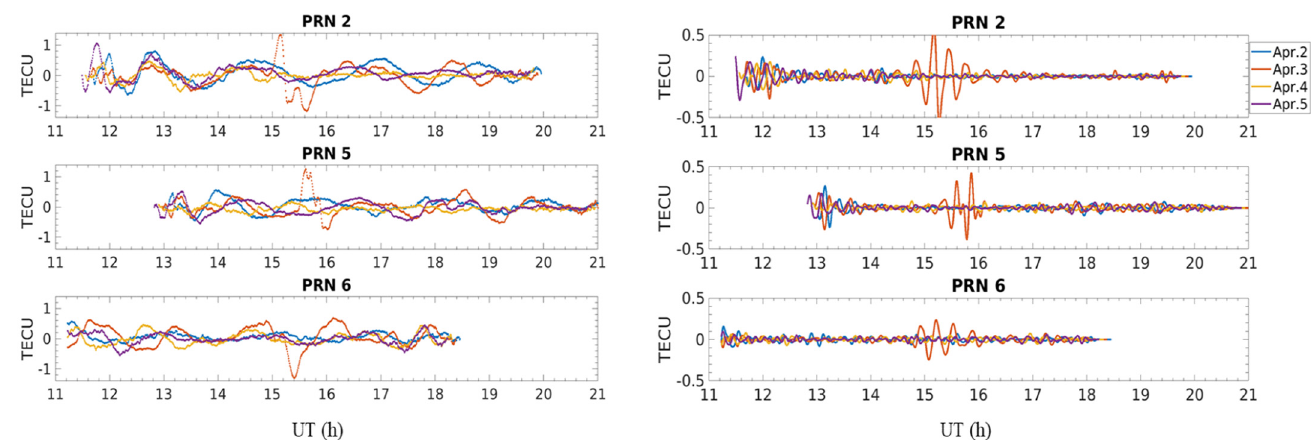
Figure 1. Observations of PRN 2, 5, and 6 at the HKWS station from 11:00 to 21:00 on 2–5 April 2019. The left panel indicates the disturbance and the right panel indicates the ionospheric GW. The three subplots indicate PRN 2, 5, and 6. The colors of the lines represent different dates: blue for 2 April, red for 3 April, yellow for 4 April, and purple for 5 April.